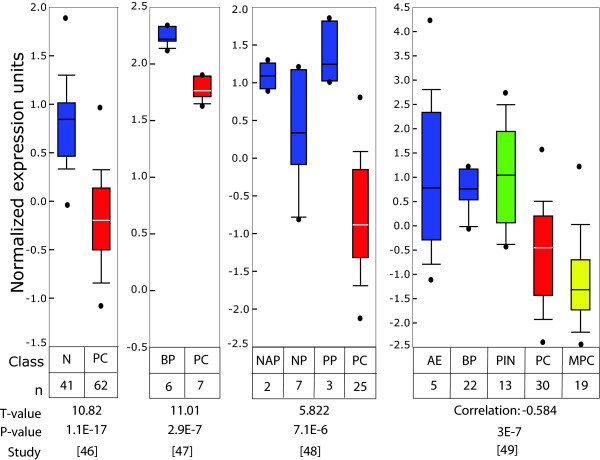
Id4 expression in prostate cancer as determined from publically deposited microarray databases. The Oncomine database was queried against Id4 and all prostate databases were analyzed. The box and whisker plots from four of these representative studies is shown [51-54]. Consolidated data from all these studies demonstrated that Id4 is significantly (T-values > 5 and low P-values < E-6) down-regulated in prostate cancer samples. Abbreviations: n: No. of samples in each analysis, PC: Prostate Cancer (Red), MPC: Metastatic prostate cancer (Yellow), NAP: Normal adjacent prostate (Blue), NP: Normal Prostate (Blue), PP: Post-pubertal prostate (Blue), BP: Benign prostatic hyperplasia (Blue), PIN: prostate intra-epithelial neoplasia (green).